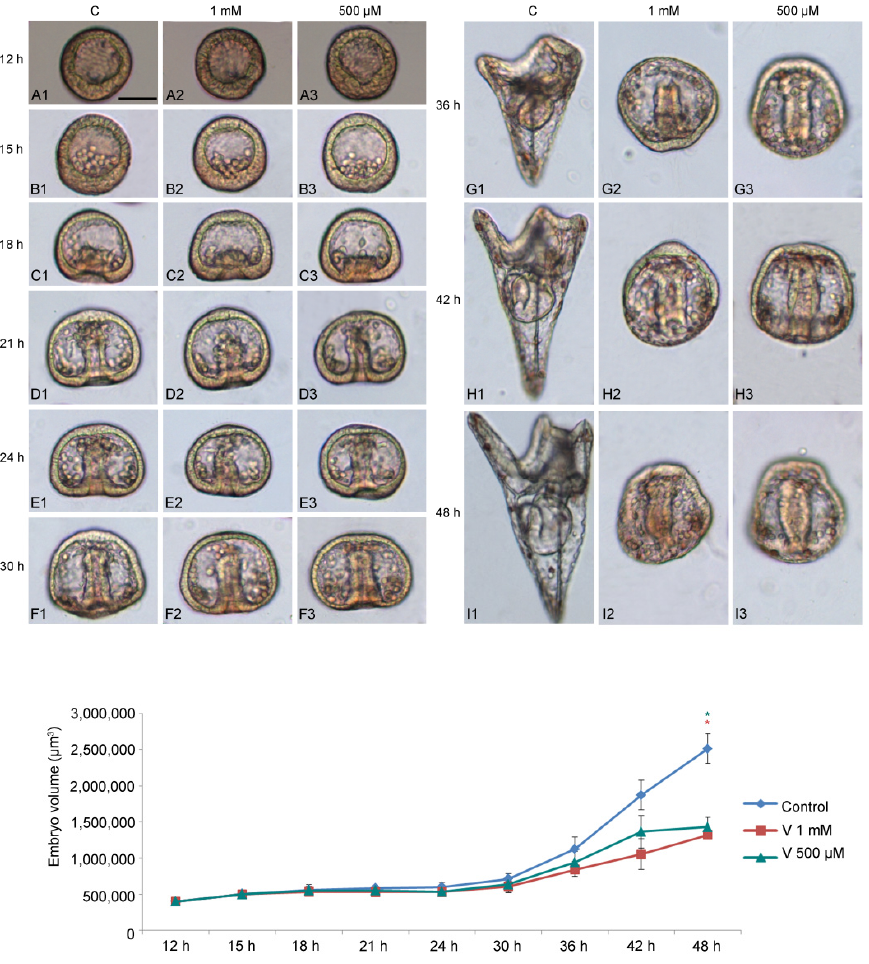
Figure 1. Morphological and morphometric effects induced by V during embryonic development. Images representative of embryos from 12 h to 48 h of development/treatment. bryos were observed at different development/treatment intervals: ( A1 – A3 ) 12 h; ( B1 – B3 ) 15 h; ( C1 – C3 ) h. Scale bar = 45 µm. Images are representative of three independent experiments. The line graph shows data related to the volumetric analysis. Experiments were performed in triplicate and data are expressed as means ± standard deviation ( n = 3 ± SD). Statistical analysis was performed using t -test with * p ≤ 0.05.